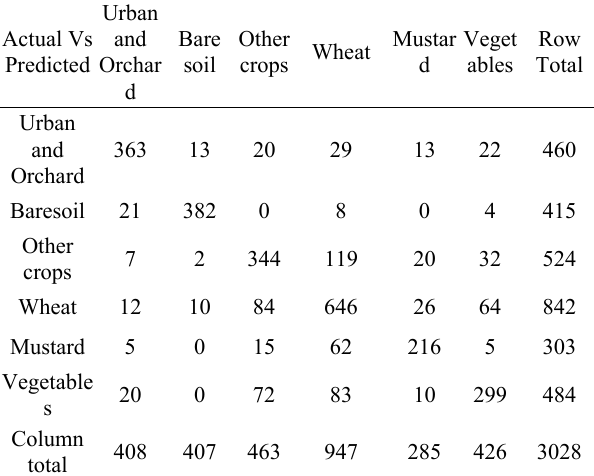
Table 3. Confusion Matrix using SVM Classification